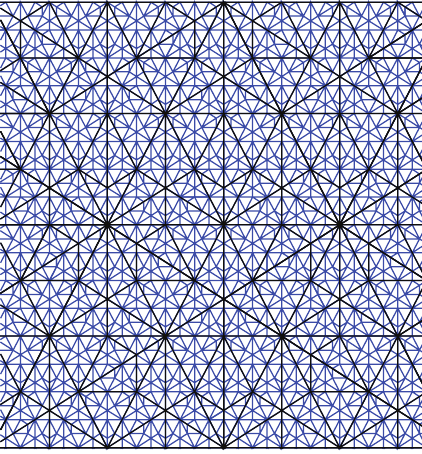
Figure 9: Level-2 supertiles in T